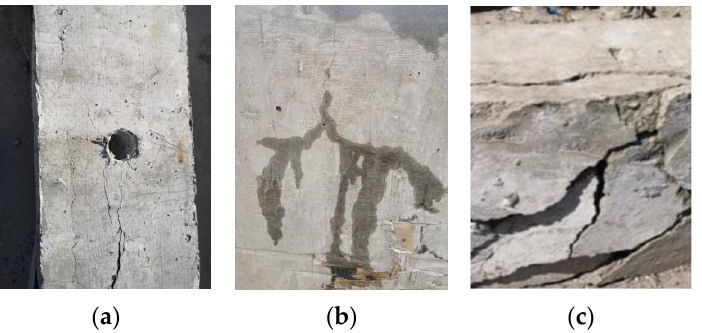
Figure 8. Breaking effect of Hole 3. ( a ) First discharge; ( b ) Fourth discharge; ( c ) Tenth discharge.